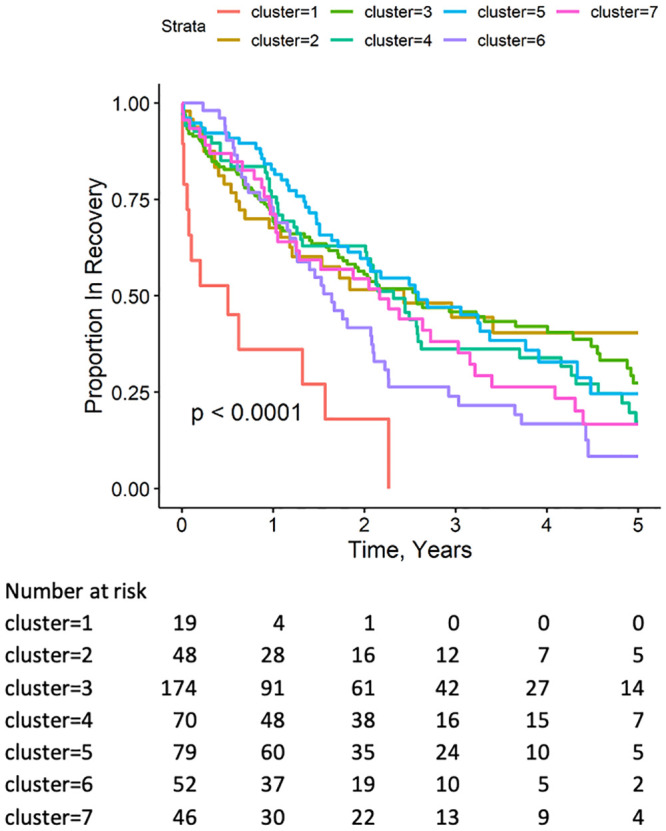
Probability of maintaining LVEF ≥ 50% during follow up.Follow up echo was available in 488/889 patients. Patients in Cluster 1 were the most likely to not have a sustained LVEF ≥ 50% during follow up. Clusters 2–7 had similarly high likelihoods of having LVEF ≥ 50% during follow up.